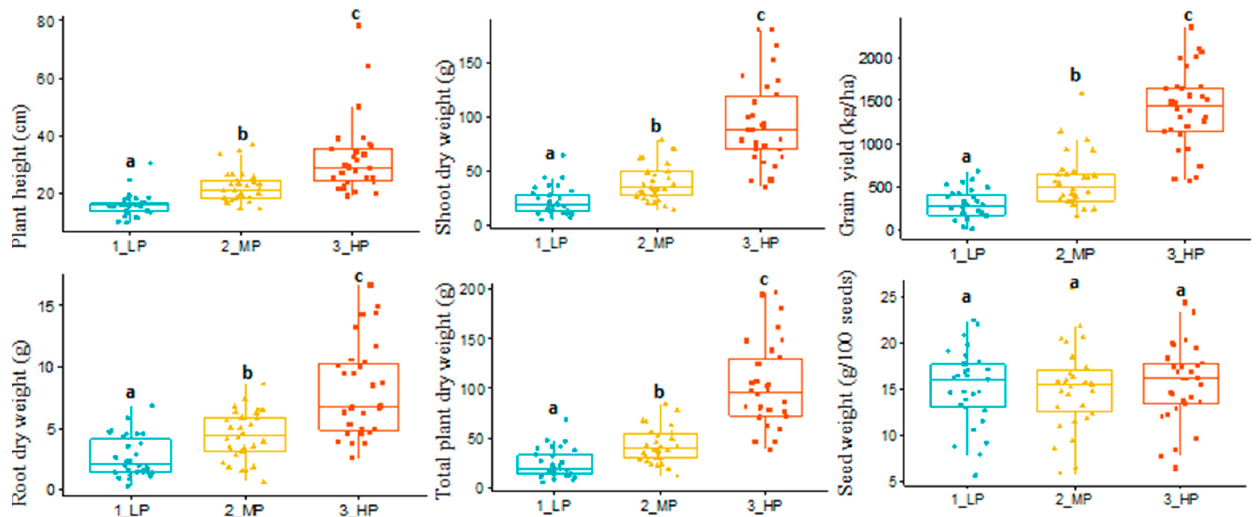
Figure 2. Phenotypic distribution of growth and yield parameters measured in the field under varying soil phosphorus levels. Box plot displays the median of each group bounded by the first and third quartile, where the X -axis is soil phosphorus concentrations, with 1_LP = no-P application, 2_MP = 10 kg P 2 O 5 ha − 1 , and 3_HP = 60 kg P 2 O 5 ha − 1 . Letters above each box plot denote similarity among groups as per Tukey’s honestly significant difference comparison test ( α ≤ 0.05). Means with the same letter are not significantly different.